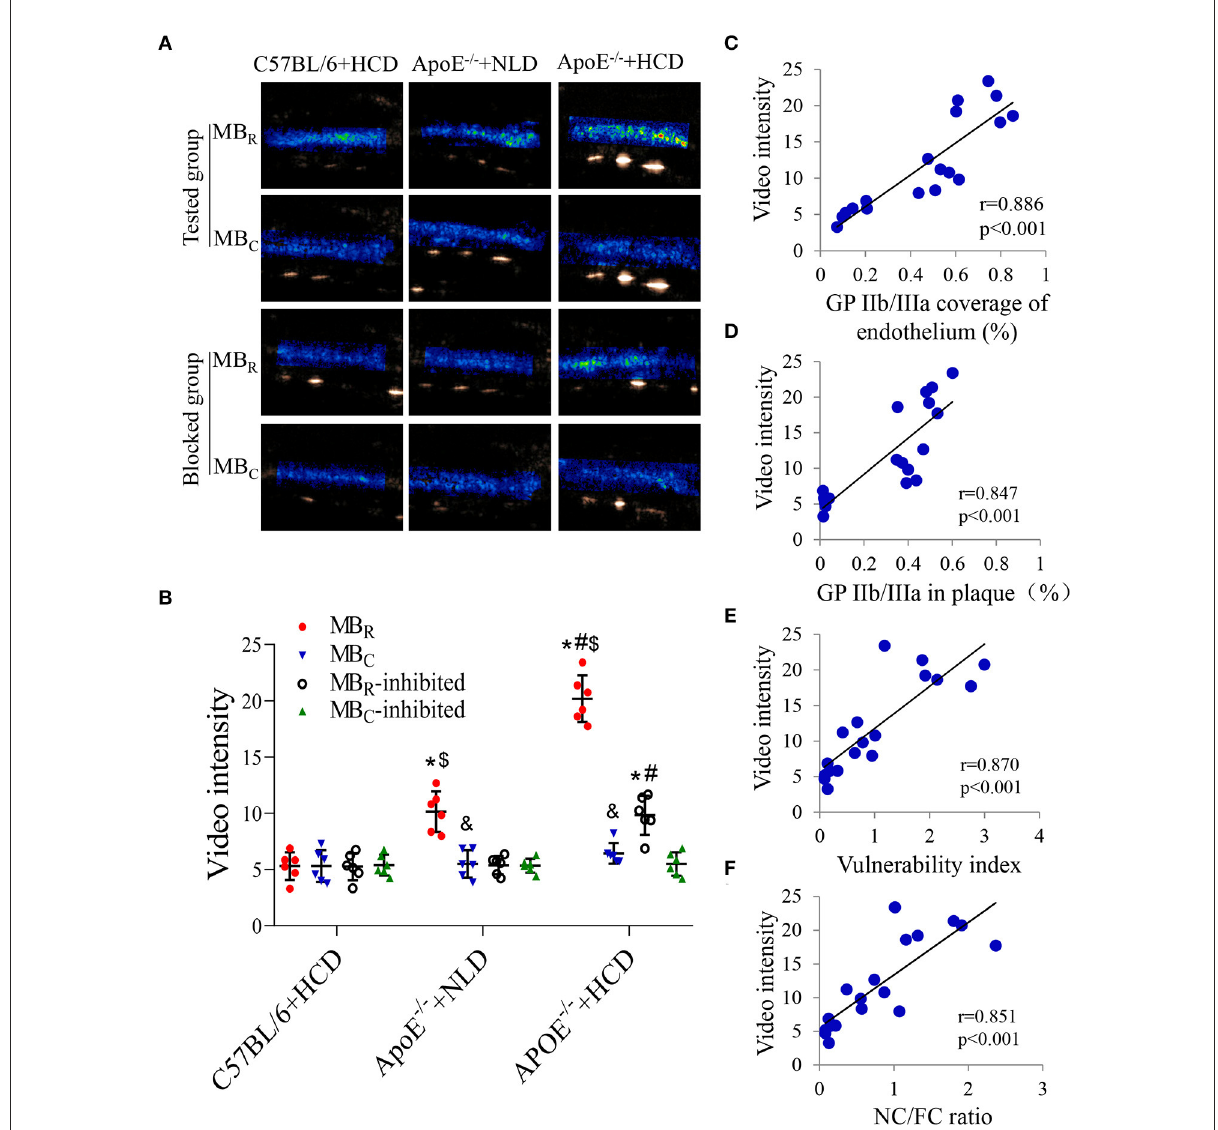
FIGURE3 Correlations between video intensity of ultrasound molecular imaging and GP IIb/IIIa expression, and the plaque vulnerability indicators. (A) Background-subtracted, color-coded images were obtained after injection of MB R or negative control (MB C ). (B) Video intensity of MB R and MB C in the tested mice and their inhibited groups were quantified ( n = 6 per group). Correlations between the video intensity of MB R in tested group and (C) GP IIb/IIIa coverage of the endothelium, (D) GP IIb/IIIa expression in plaques, (E) the plaque vulnerability index, and (F) the NC/FC ratio are shown. n = 6 per group. Data represent the mean ± standard deviation. * P < 0.05 vs. C57BL/6 + HCD, # P < 0.05 vs. ApoE − / − + NLD, & P < 0.05,